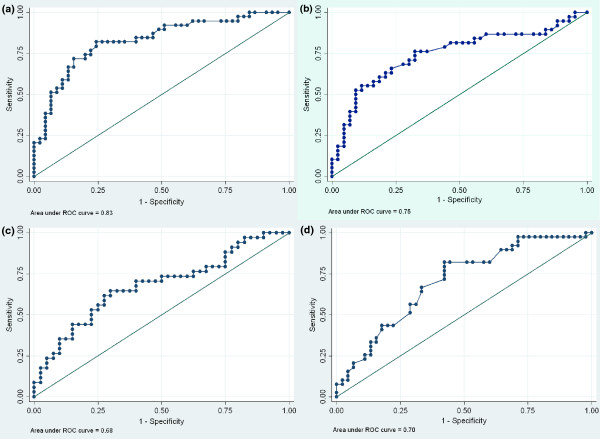
Receiver operating characteristic curve showing the ability of variables to predict a later requirement for dialysis in those patients who should have received dialysis. 3a) Plasma creatinine 3b) Fractional excretion of sodium 3c) Urinary neutrophil gelatinase-associated lipocalcin 3d) Plasma bicarbonate.